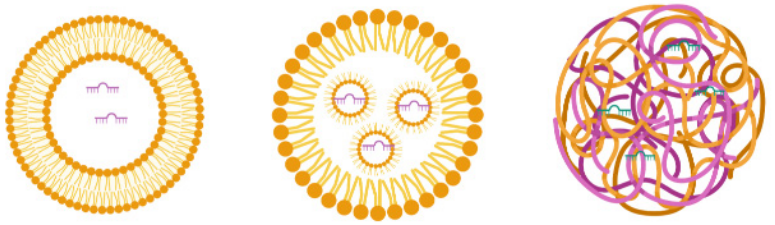
Figure 3. The general structure of the liposome, lipid nanoparticles, and solid lipid